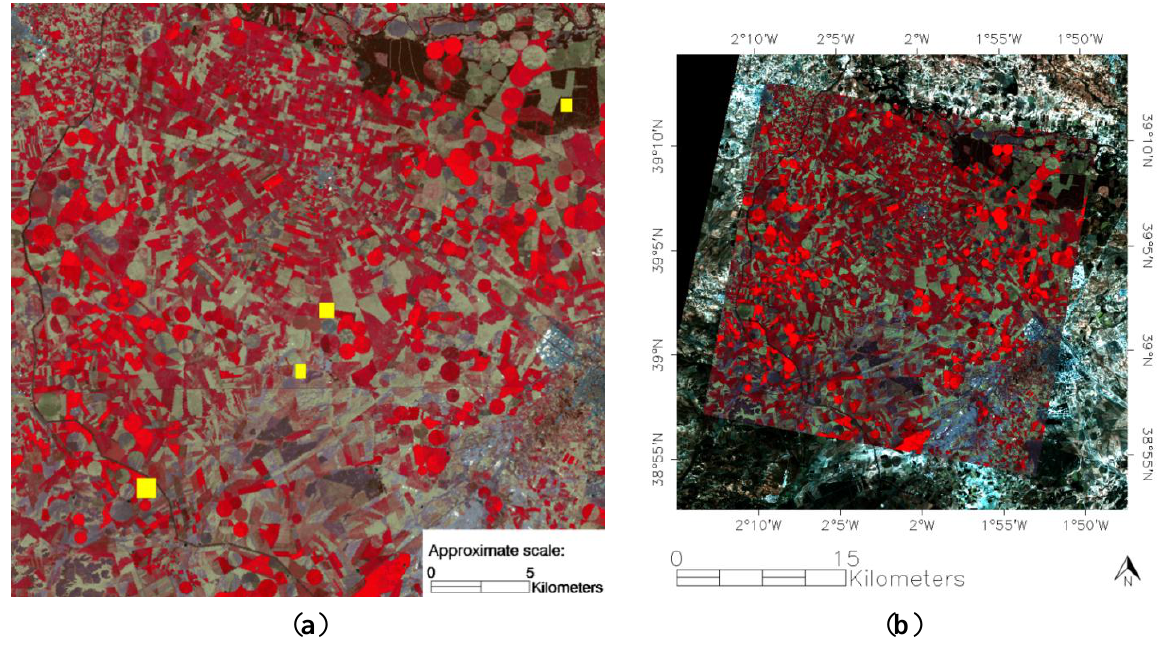
Figure 1. Overview of the simulated EnMAP scene “Barrax”; ( a , left) colour infrared composite in original sensor geometry (channels at 895, 652, 548 nm used for R-G-B, linear image stretch); the regions of interest used in this study are represented by yellow boxes of the approximate size; ( b , right) for illustration: overlay of the same image as in ( a ) on an ortho-rectified Landsat 8 scene displayed as true colour composite (Landsat 8 channels 3-2-1 used for R-G-B, linear image stretch).